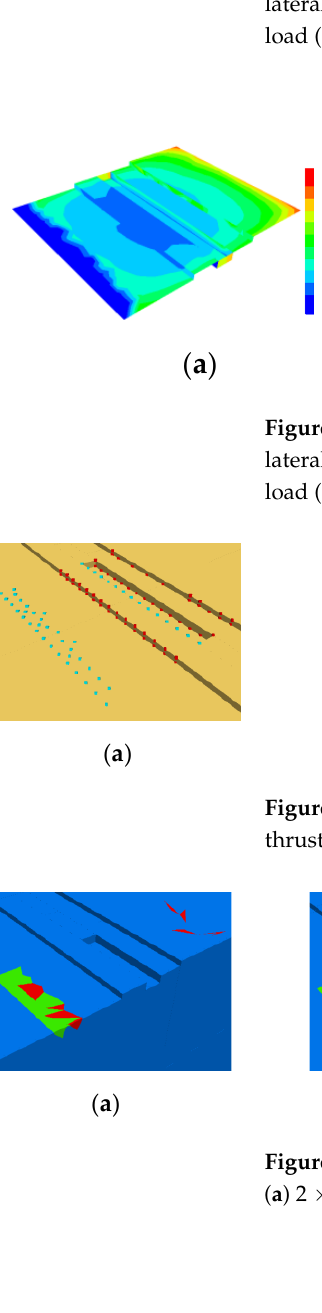
Figure 21. Sketched contour of the foundation rock mass surface after the overloading test (3 × design load). 4.3. Effect of Keyway and Platforms This section would demonstrate the anti-sliding effect of the keyway and platforms that are underneath the anchorage. Generally, the existence of a keyway and a platform can notably improve the anti-sliding and anti-overturning stability of the anchorage. However, due to the insufficient development of the design theory, traditionally the effect of the anti-sliding measures, such as keyway and platform, are hardly evaluated in a quantitative way. Thus, these measures generally provide shear resistance in terms of pas- sive lateral earth pressure and were merely being considered as the reserved stability fac- tor. Here the anti-sliding and anti-overturning effect of the keyway and platforms of the scale model would be evaluated with the DEM modelling. Figure 22 gives the comparison of DEM predicted displacements with/without anti- slip measures at the initial loading phase. The scale model results were termed as the benchmark results in Figure 22, while the results of the model without keyway and plat- form were termed as the WK results. It is evident that the consideration of keyway and platform can largely improve the horizontal and vertical equivalent stiffness of rock mass beneath the anchorage model by about 10% and 20%, respectively.